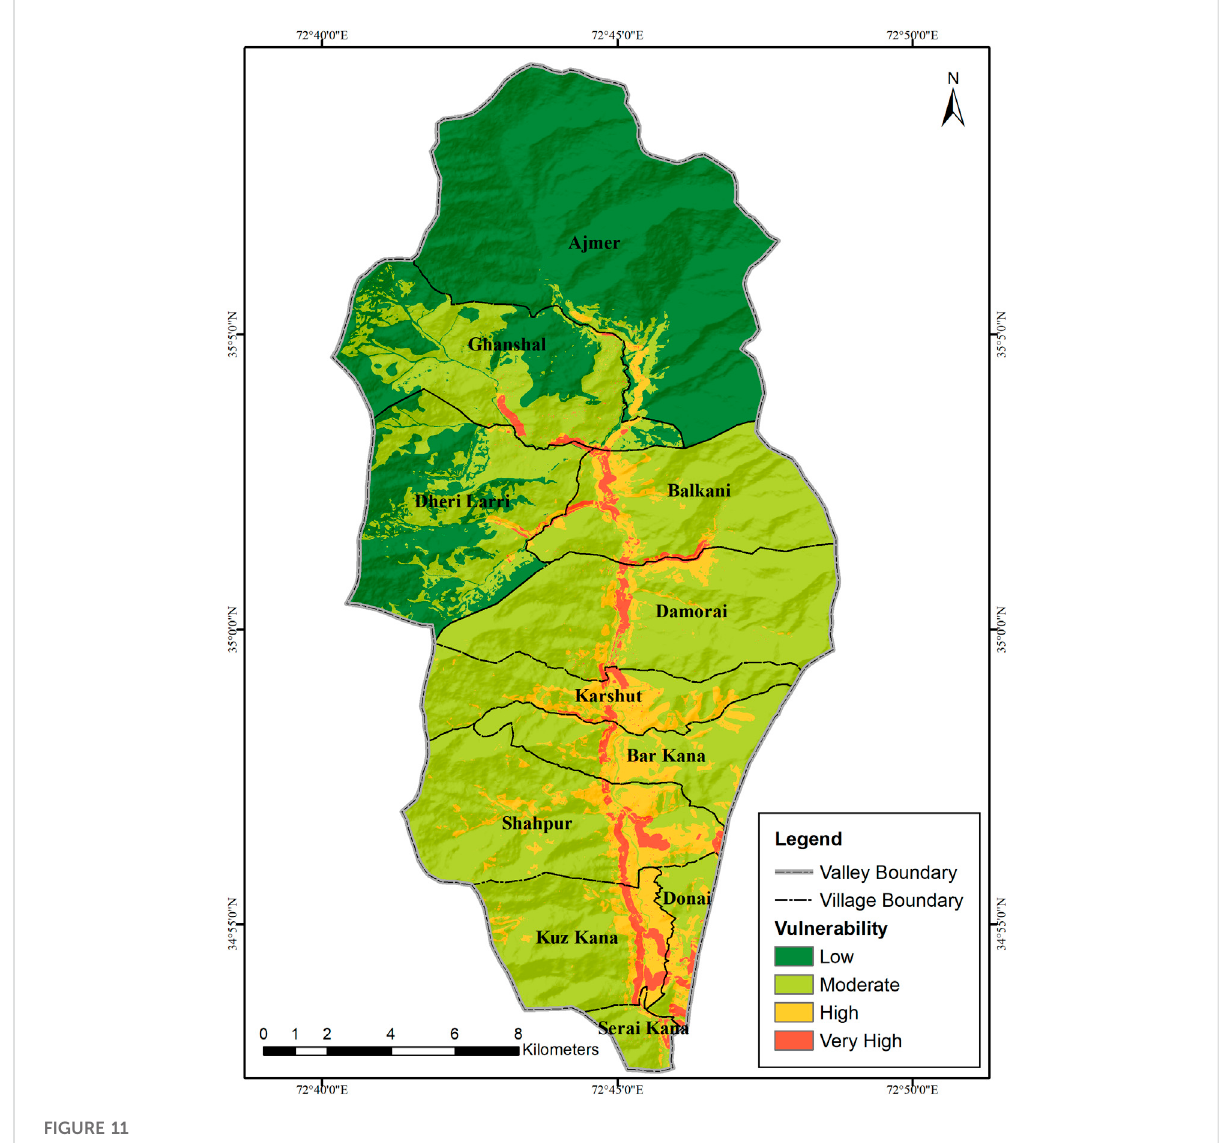
FIGURE 11 Shahpur valley: vulnerability